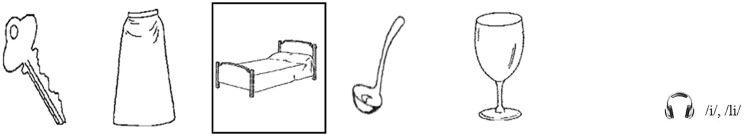
An example of a trial for the familiarization phase. Participants saw the picture of a bed that was indicated by a rectangular frame, and heard the vowel /i/ and the word “lit” (“bed”) via headphones.